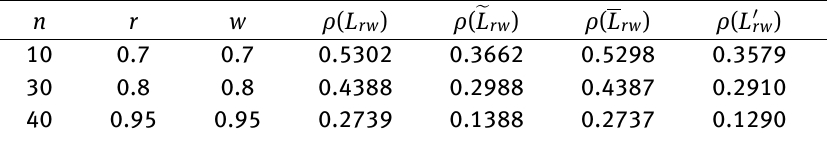
Table 2: Comparison of spectral radius of SOR scheme.